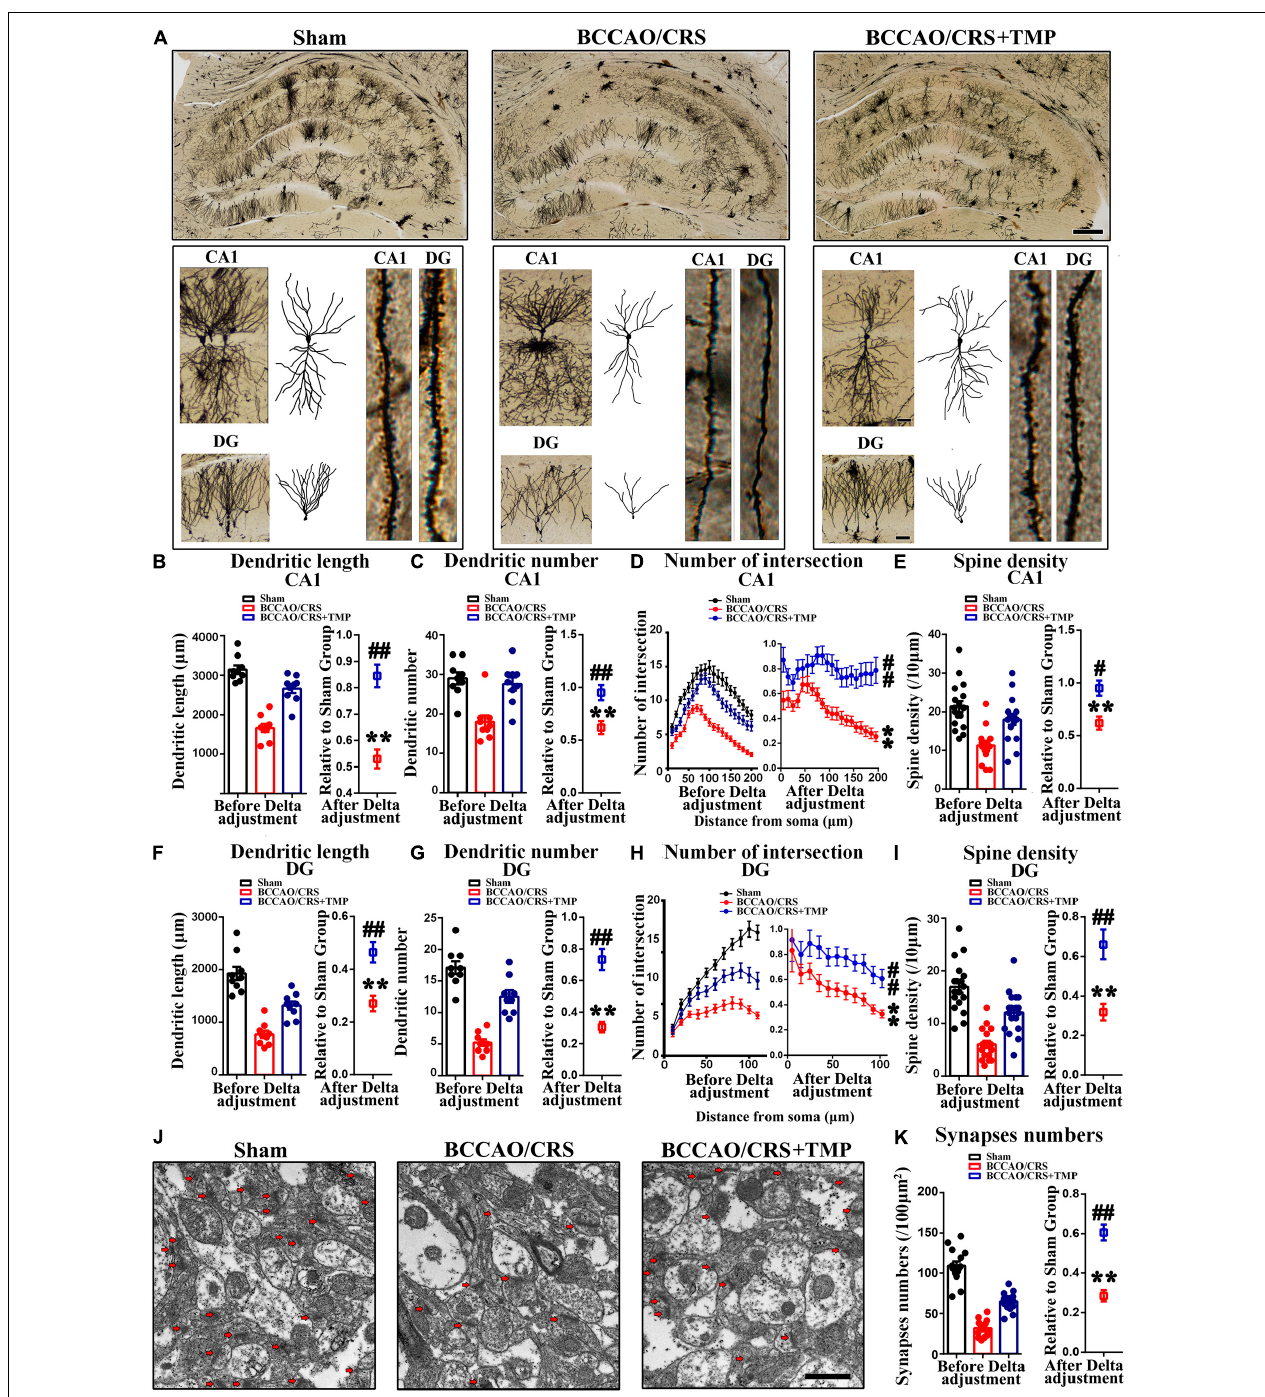
FIGURE 6 | TMP attenuates dendritic and spine deficits in hippocampus in BCCAO/CRS rats. (A) Representative Golgi-Cox staining images exhibiting dendritic arborization in hippocampal CA1 pyramidal neurons and DG granular neurons in hippocampal slices. Scale bar: 400 µ m; and 50 µ m for enlarged inserts. (B) Quantification of the length of dendrites in hippocampal CA1 pyramidal neurons. (C) Bar chart indicating the number of dendrites in hippocampal CA1 pyramidal neurons. (D) Quantitative analysis of the number of intersections of dendrites in hippocampal CA1 pyramidal neurons. (E) Spine density of dendrites in hippocampal CA1 pyramidal neurons. (F) Quantification of the length of dendrites in hippocampal DG granular neurons. (G) Quantification of the number of dendrites in hippocampal DG granular neurons. (H) Chart indicating the number of intersections of dendrites in DG granular neurons. (I) Spine density of dendrites in hippocampal DG granular neurons. (J) Representative images of hippocampal synapses under transmission electron microscope (TEM). Scale bar: 1 µ m. (K) Quantitative statistics of hippocampal synapses in different groups. ** P < 0.01 vs. Sham. # P < 0.05, ## P < 0.01 vs. BCCAO/CRS. Data are presented as mean ± SE. n = 3 in each group, and 3 slices per rat for Golgi-Cox staining, 5 random fields per rat for TEM.